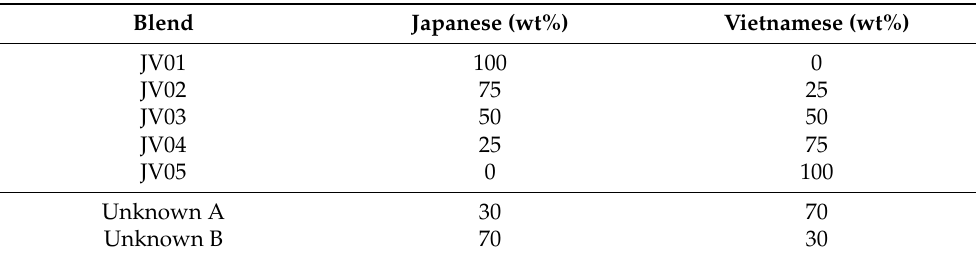
Table 1. Compositional ratios of blended Japanese and Vietnamese lacquers.